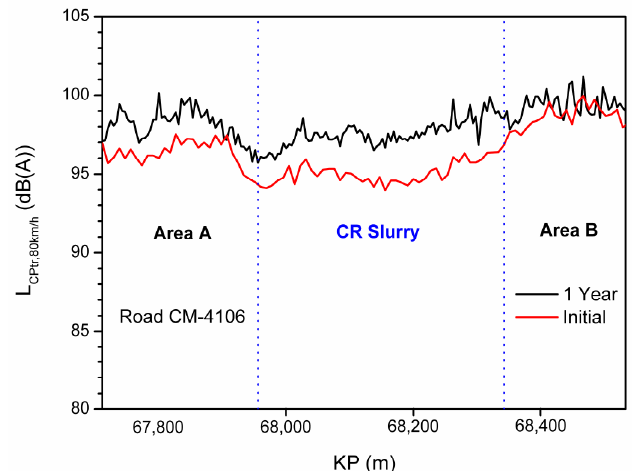
), acoustical variability ( σ ) and total CPtr,80 km/h